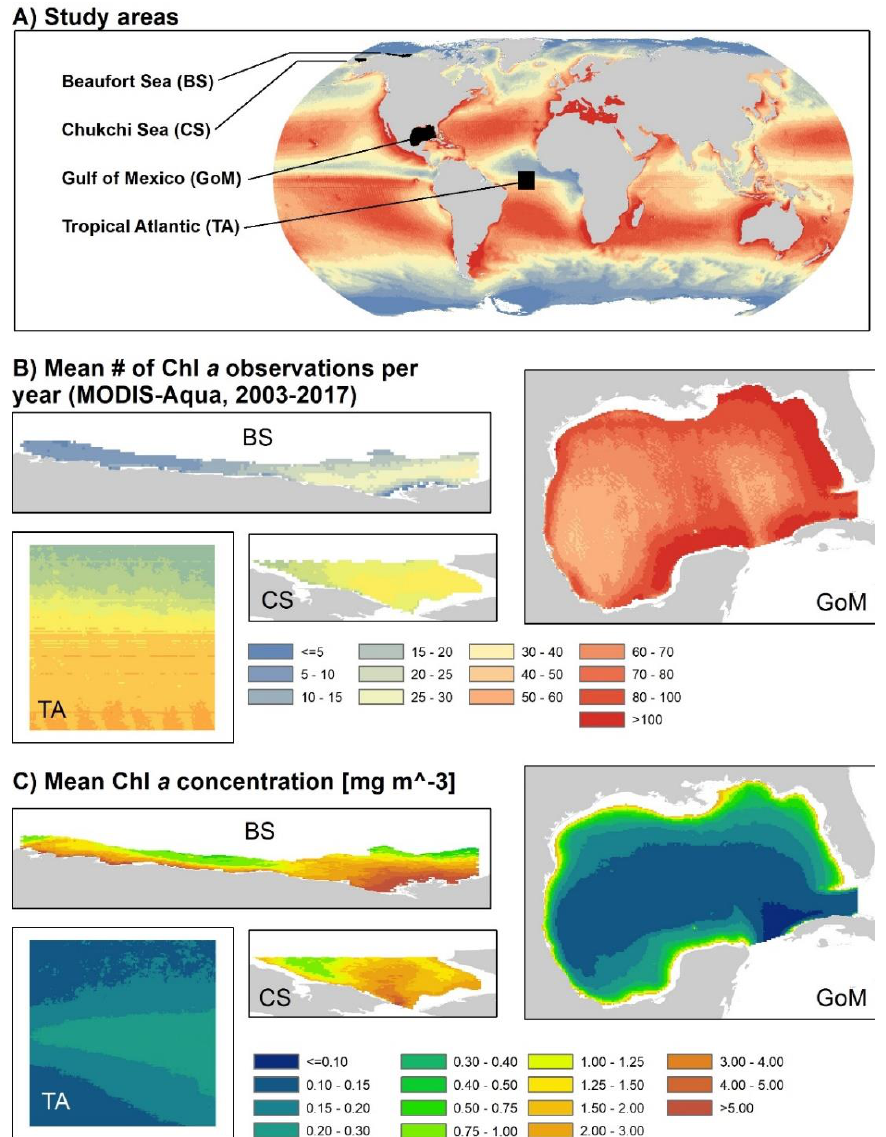
Figure 1. The four study areas ( A ), their mean number of MODIS-Aqua Chl a observations in daily L3m data per year in 2003–2017 ( B ), as a proxy for data gaps caused by cloud cover), and their mean Chl a concentration ( C ) during the respective study seasons (1998–2017). Panel ( A ) has the same color scale as panel ( B ). Note that the number of observations in panels ( A , B ) are shown as an annual average, but our study period in the Beaufort Sea (BS) and Chukchi Sea (CS) covered only the summer months when observations are more frequent. Grey areas represent land.